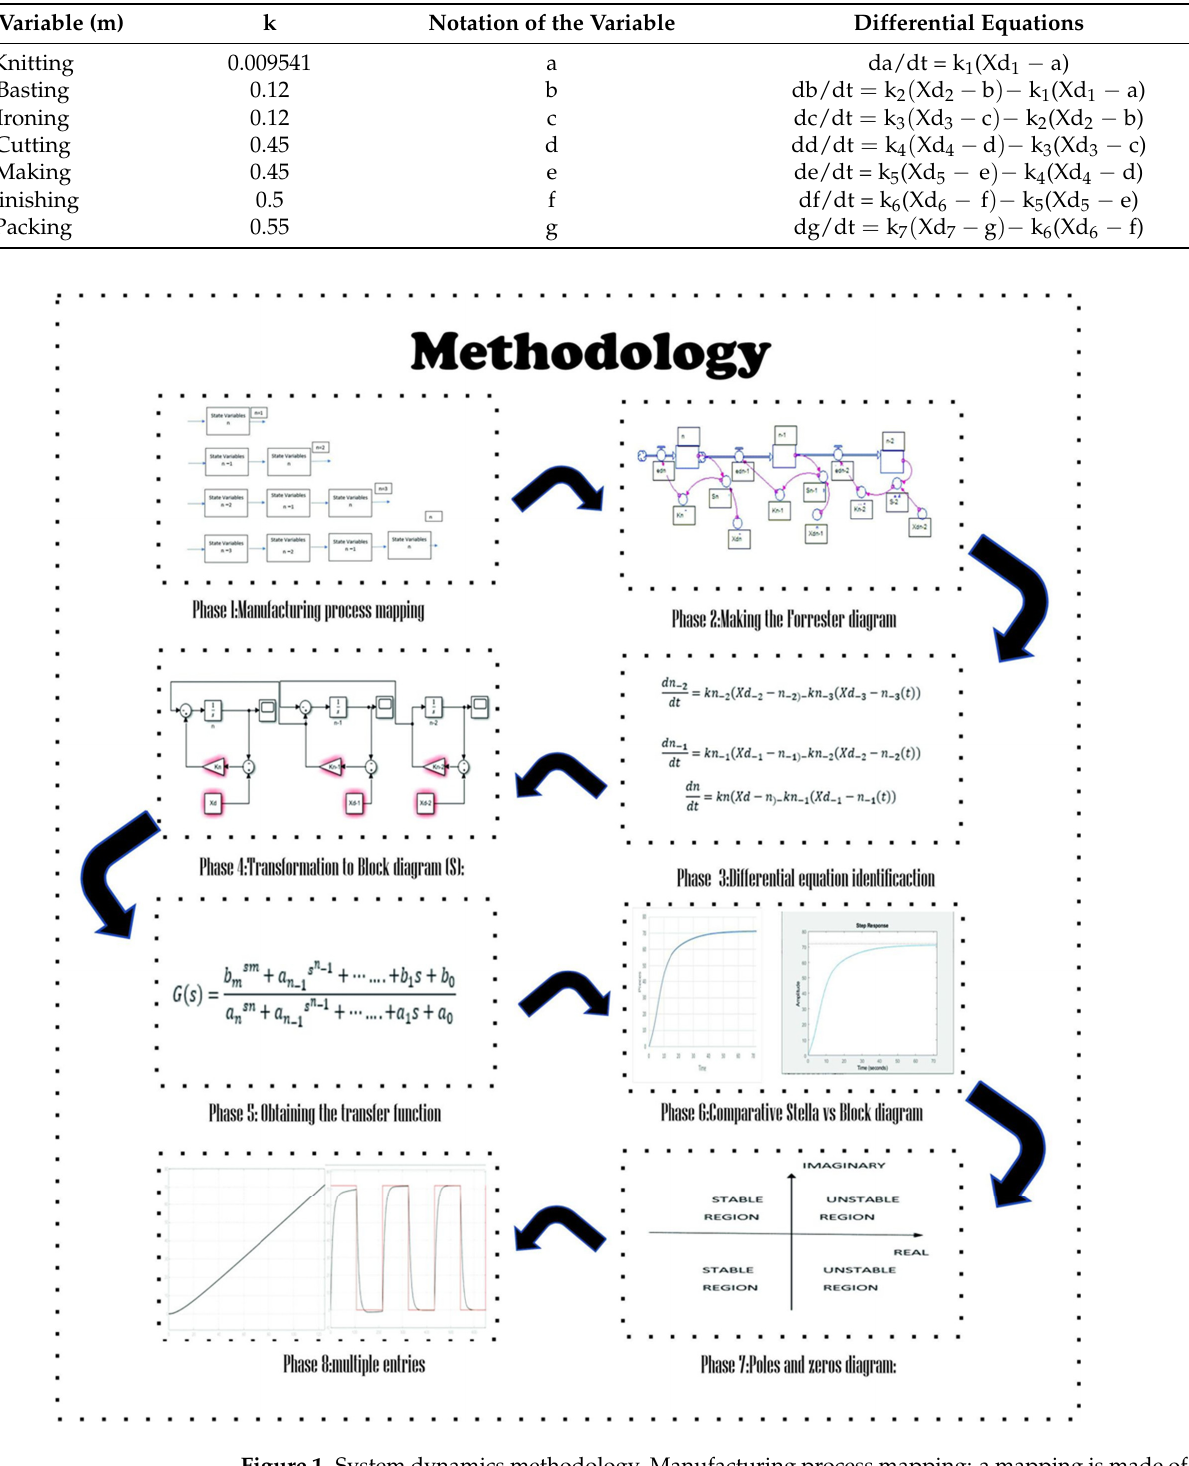
Table 2. Data on auxiliary variables and notation of state variables.